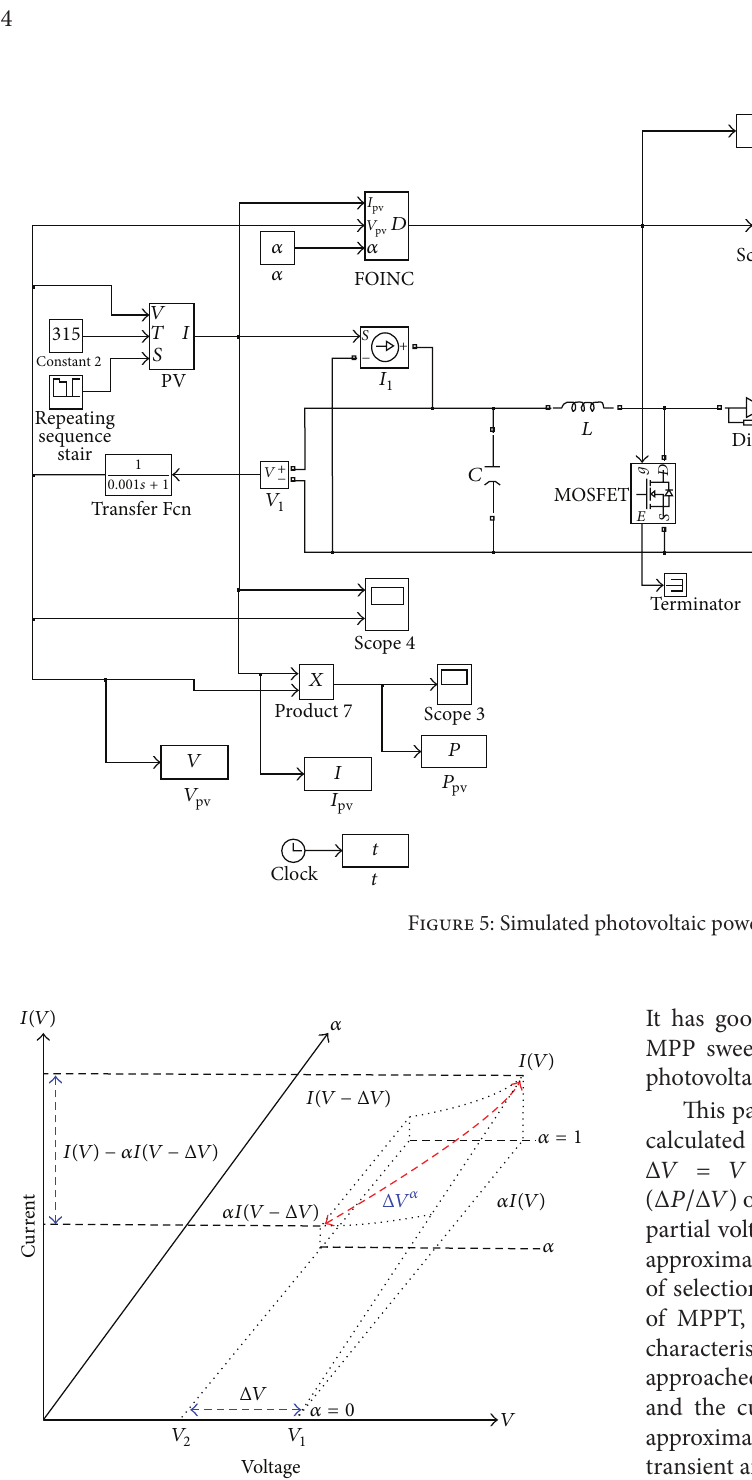
Figure 6: Geometric interpretation of Δ𝑉 in fractional-order